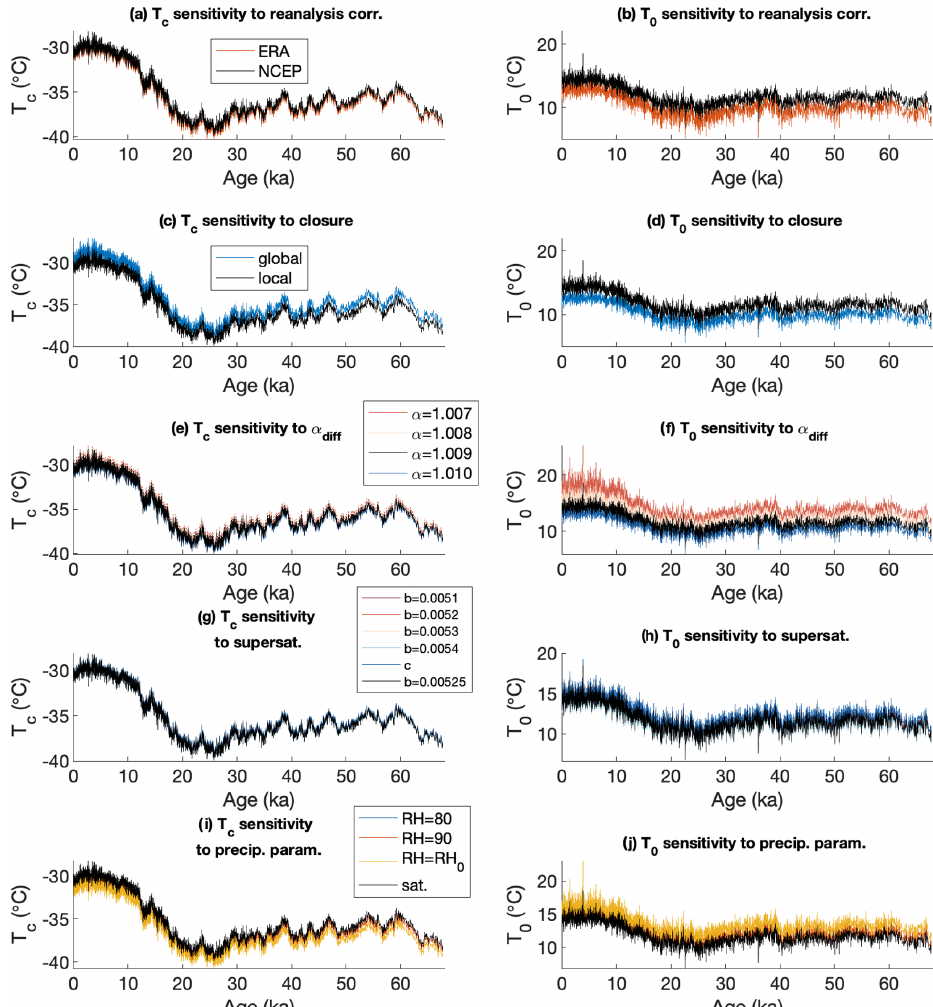
Figure A25. Temperature reconstruction sensitivity to model parameterizations. T c and T 0 reconstructions using WDC δ 18 O and d ln (re- sampled to 10-year resolution) as well as SWIM runs. Black lines show the base model in all panels, while colored lines are results in which model parameters and assumptions are varied: (a–b) evaporation condition correlations based on NCEP (black) and ERA (red) reanalysis data; (c–d) global (blue) and local (black) closure assumption during evaporation. (e–f) A range of values for 18 α diff ; (g–h) a range of values for the b parameter in the supersaturation parameterization, as well as a nonlinear parameterization (c) as described in the text; (i–j) several versions of the precipitation parameterization in which all moisture is removed above saturation (sat), all moisture is removed above initial RH (RH = RH 0 , constant RH along path), and all moisture is removed above fixed 80% or 90%